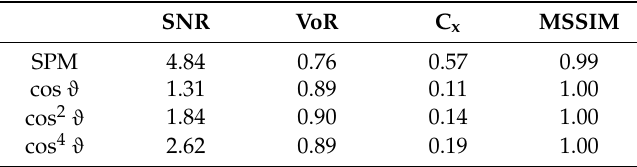
Table 3. Performance parameters of